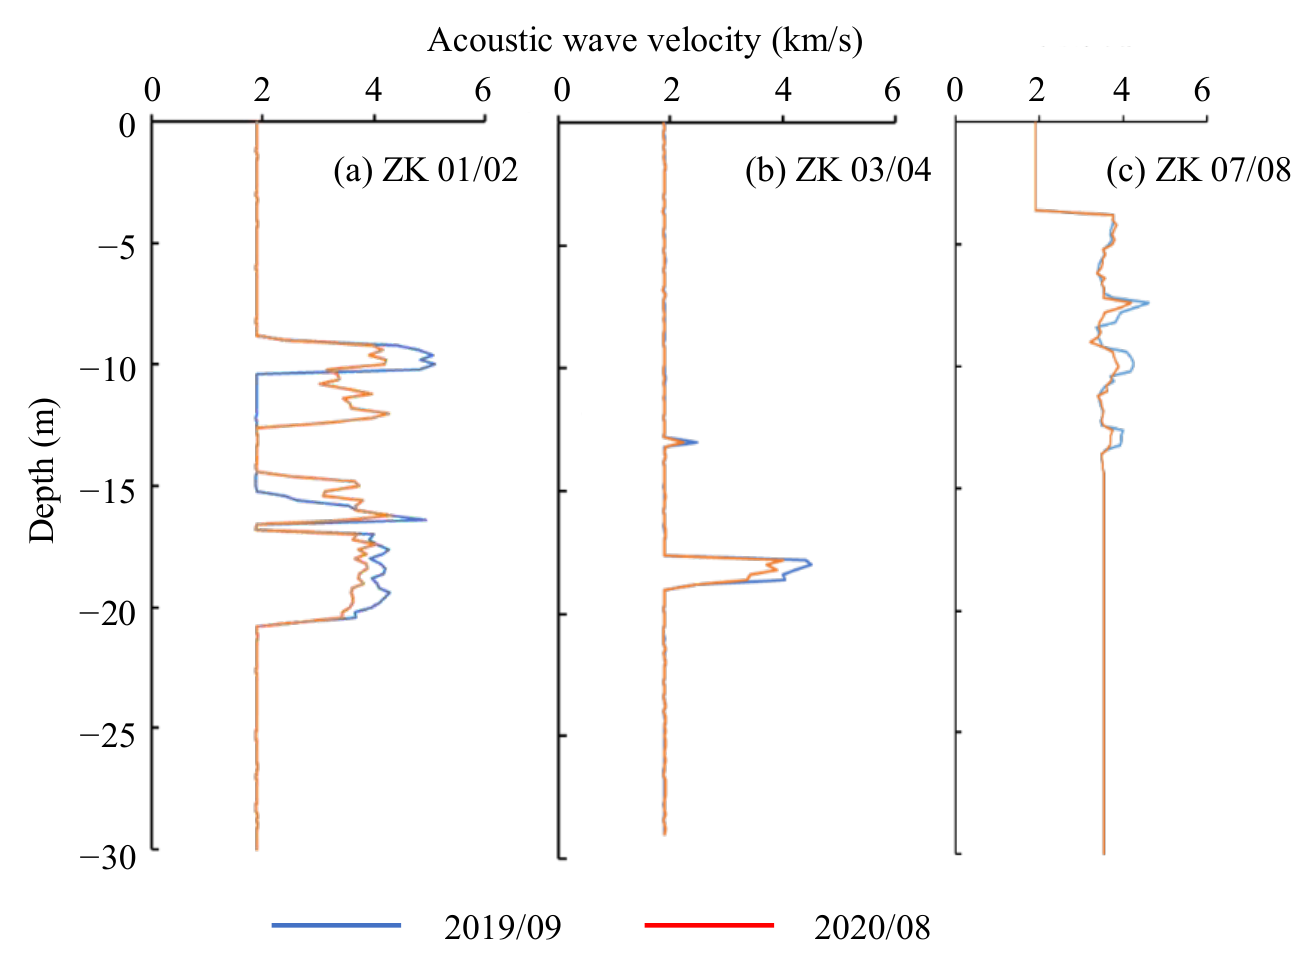
Figure 20. Curves of the cross-borehole acoustic wave velocity changing with depth. Table 3. Wave velocity of the sandstone